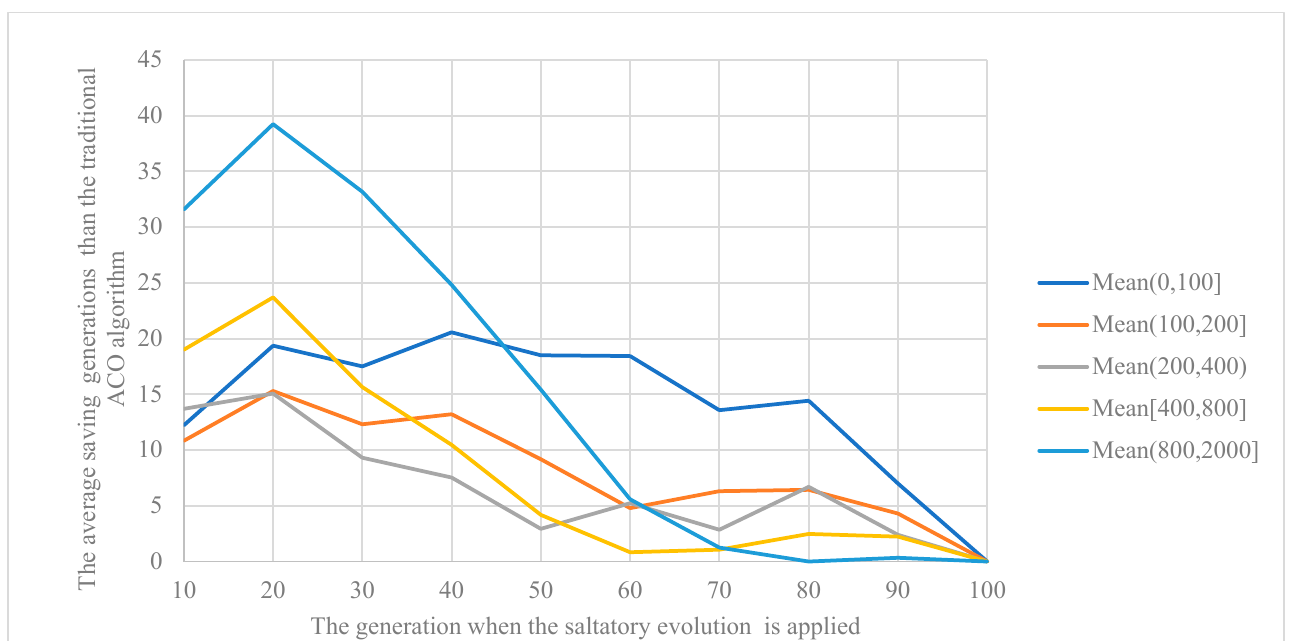
Figure 10. The average optimization results of SEACO algorithm on different data groups.